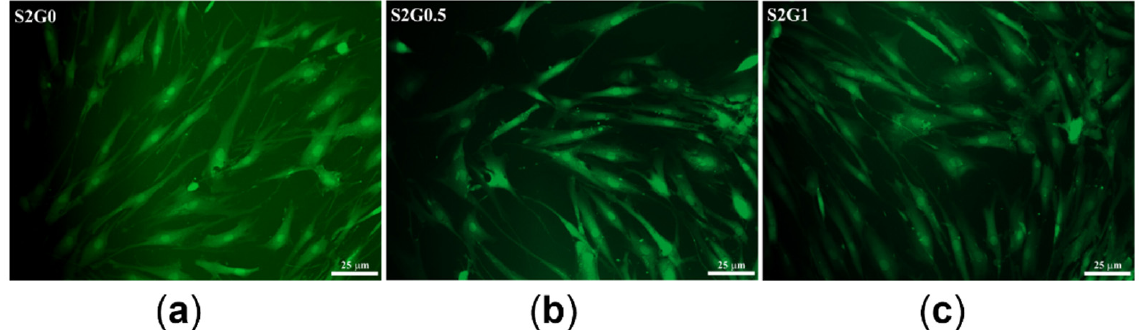
Figure 8. Fibroblasts cell viability seeded onto hydrogel discs ( n = 3).